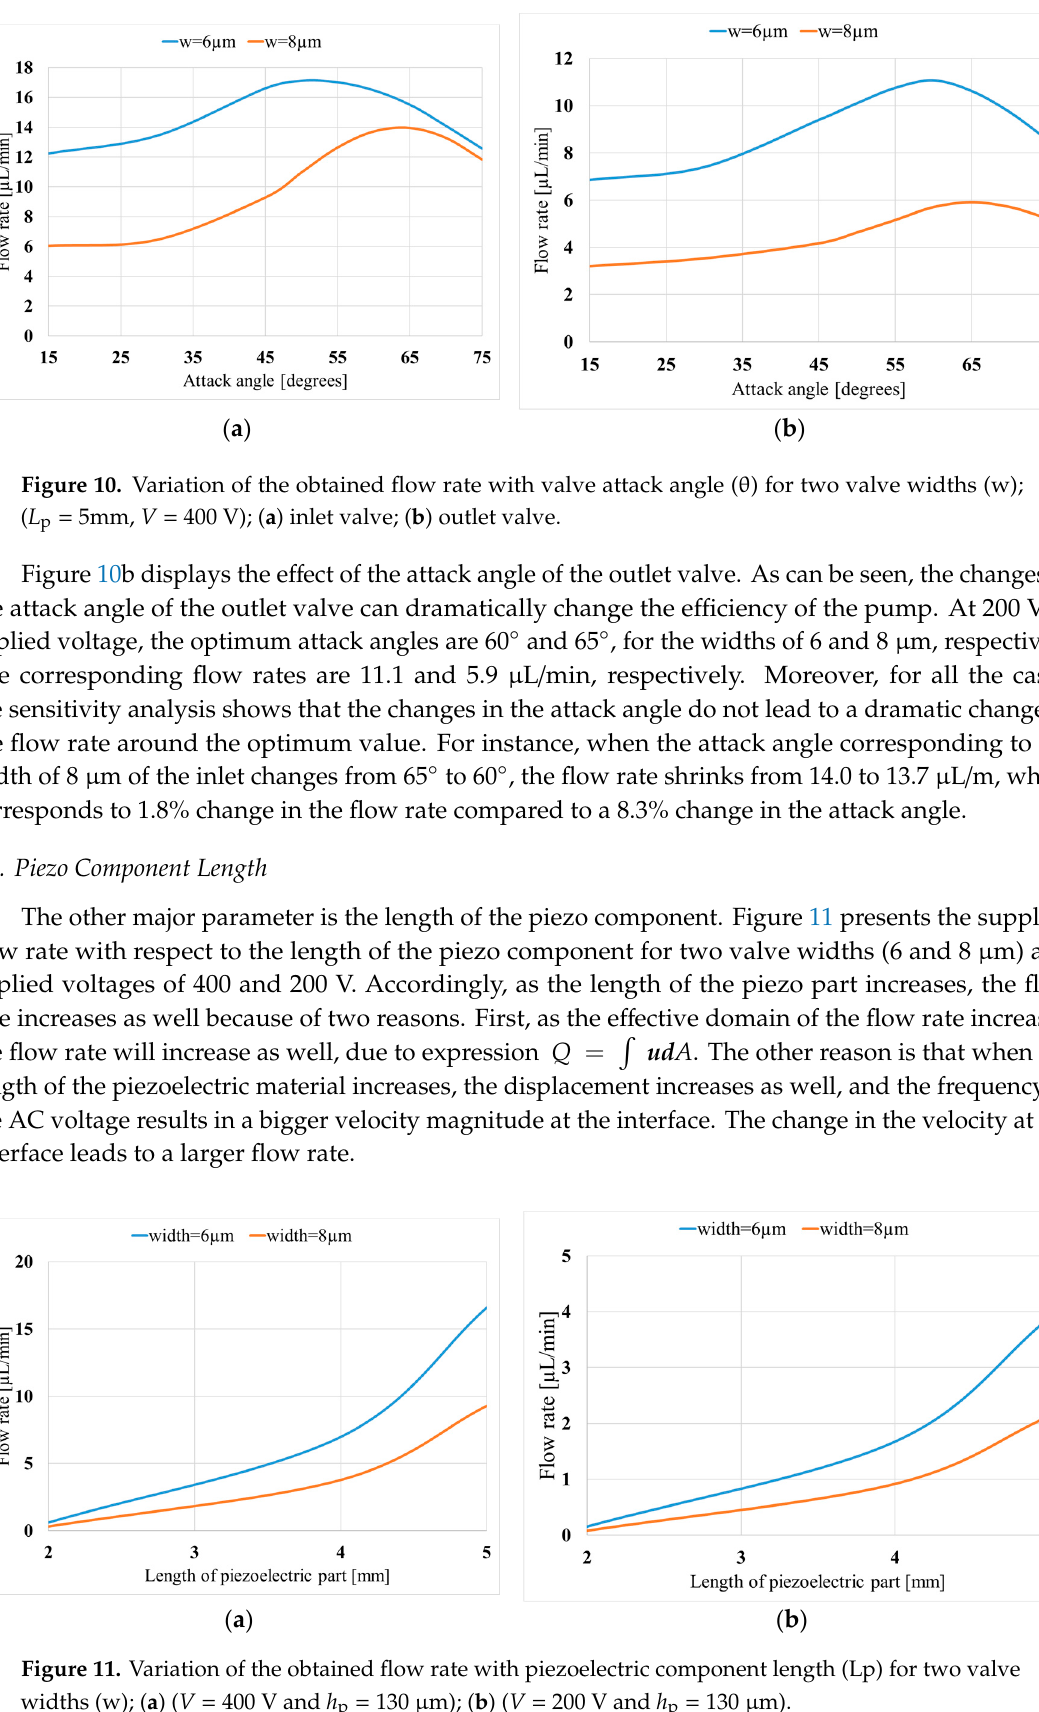
Figure 11. Variation of the obtained flow rate with piezoelectric component length (Lp) for two valve widths (w); ( a ) ( V = 400 V and h p = 130 μ m); ( b ) ( V = 200 V and h p = 130 μ m).